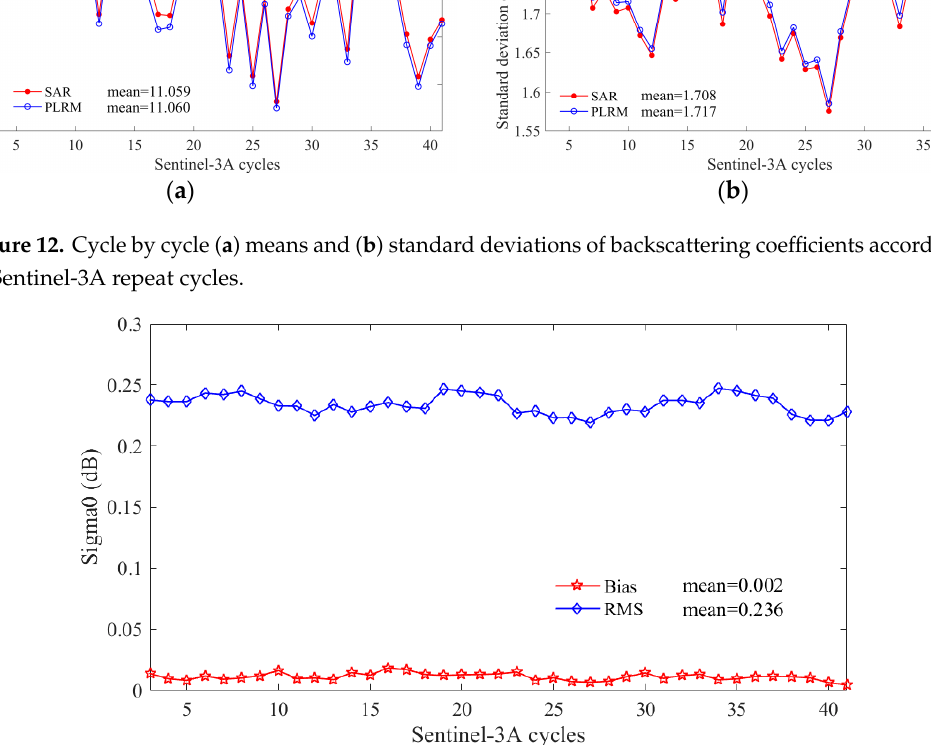
Figure 13. Cycle by cycle biases and RMSEs of differences of backscattering coefficients between SAR and PLRM mode.